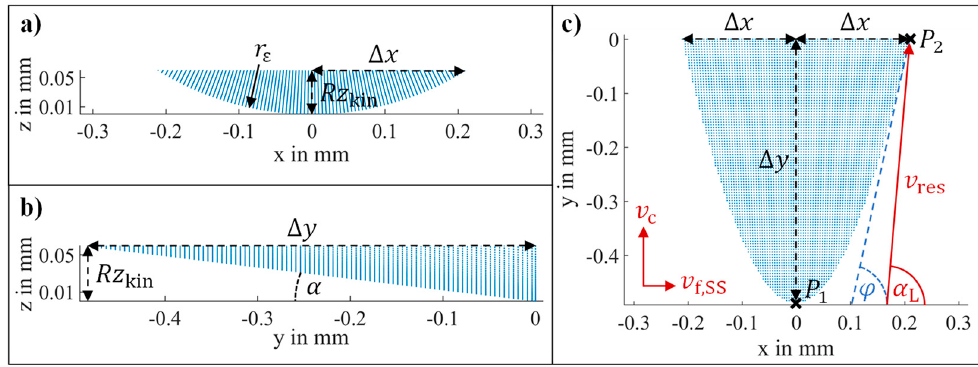
Figure 3. Discrete point representation of the tool body and its relevant geometrical parameters in the 𝑥 - 𝑧 plane ( a ), 𝑦 - 𝑧 plane ( b ) and 𝑥 - 𝑦 plane ( c ).